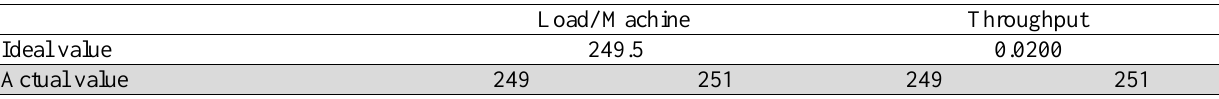
Results value Load/ Machine Throughput Ideal value 249.5 0.0200